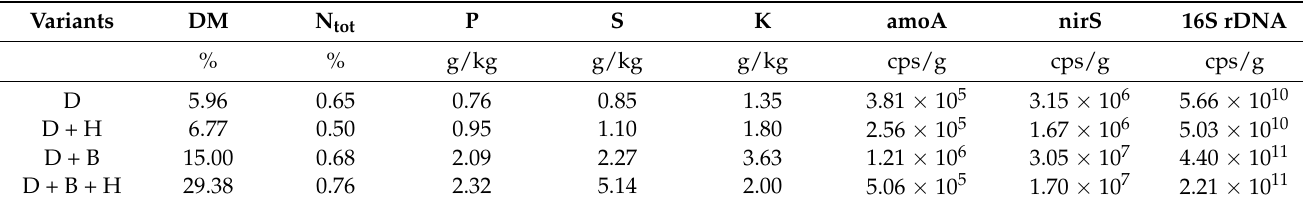
Table 2. Properties of digestate experimental